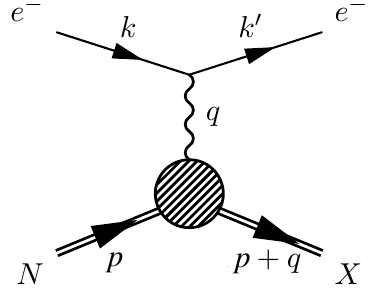
Figure 1: DIS, where k , k (cid:48) represent the incoming, outgoing lepton momenta, p is the momentum of the incoming nucleon of mass M transfer and X represents the recoiling